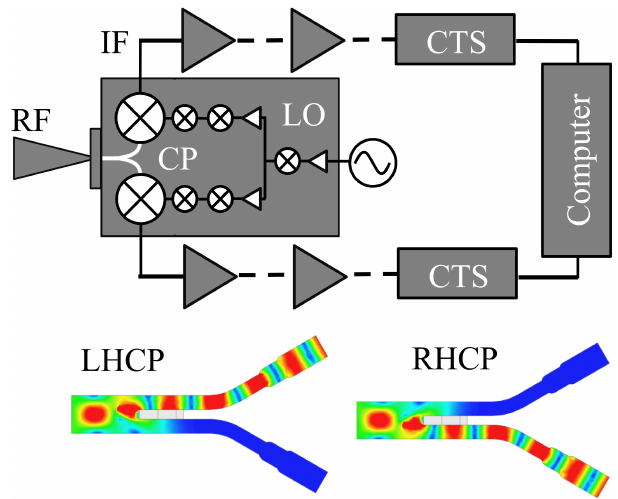
Figure 1. Sketch of sensor electronics design. The radio frequency (RF) between 474.65–475.65 and 486.65–487.65GHz enters from the left in the figure and is split by a circular polarizer (CP) into left-handed, and right-handed, circular polarization (LHCP, RHCP) as demonstrated in the colored plots above. The signal is then mixed with the signal of a local oscillator at 481.15GHz, to lower the frequency to a measurable range. At an intermediate frequency of 6GHz, the chirp transform spectrometer turns this analog signal into a digital signal that is fed into a computer for preparations and to be sent back to